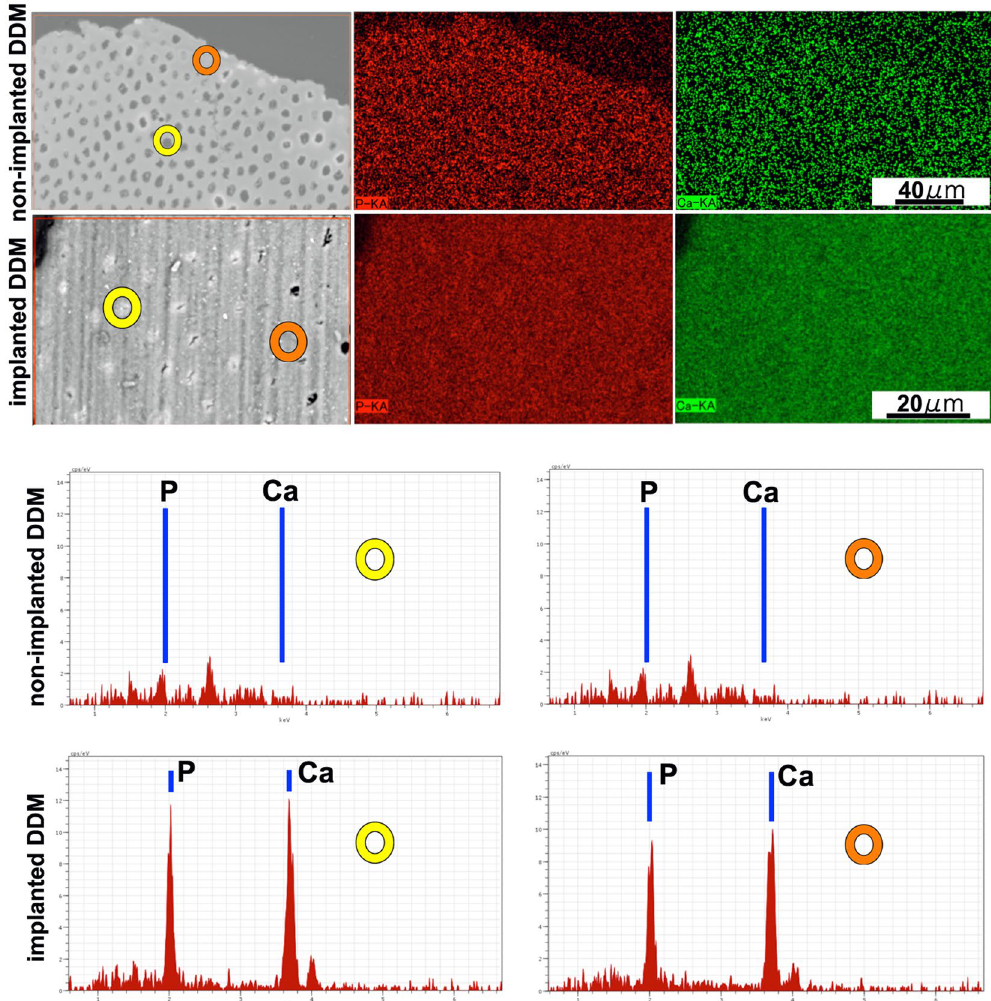
Figure 5. Elemental analysis of dentinal tubules, based on energy-dispersive X-ray spectrometry. The yellow circles indicate the dentinal tubules, and the orange circles indicate the matrix. The Ca and P levels are higher in the implanted demineralised dentin matrix (DDM) particles than in the non-implanted DDM particles on the polished surface. The Ca and P levels are higher in the dentinal tubules than in the